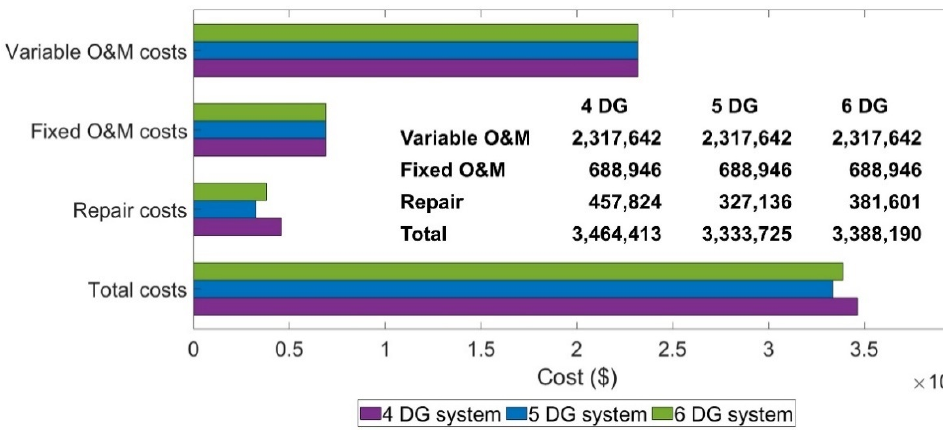
Figure 18. Annual maintenance service costs breakdown at a 3 pu load.